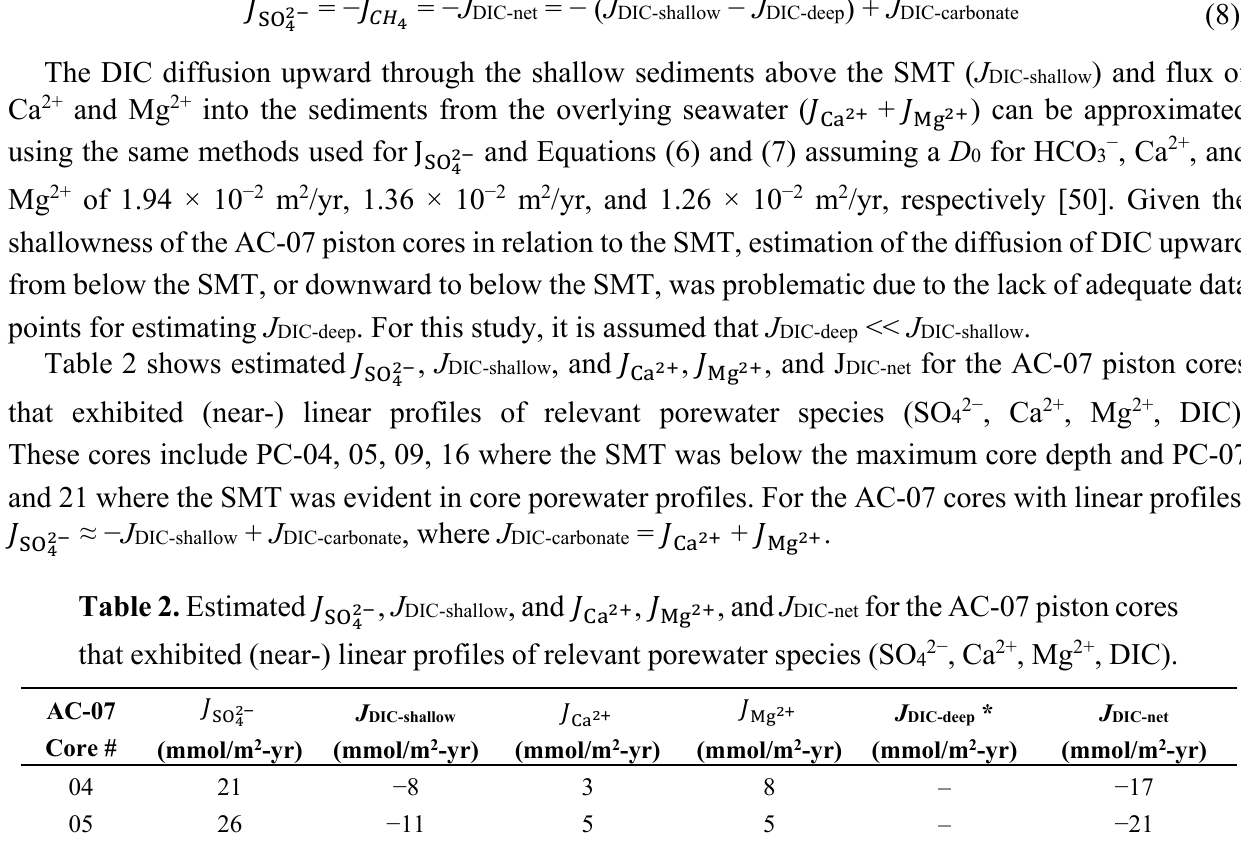
Table 2. Estimated (cid:1836) , J DIC-shallow , and (cid:1836) (cid:2903)(cid:2899) (cid:3120)(cid:3118)(cid:3127) that exhibited (near-) linear profiles of relevant porewater species (SO 42 − , Ca 2+ , Mg 2+ , DIC). (cid:1836) AC-07 J (cid:2903)(cid:2899) (cid:3120)(cid:3118)(cid:3127) Core # (mmol/m 2 -yr)